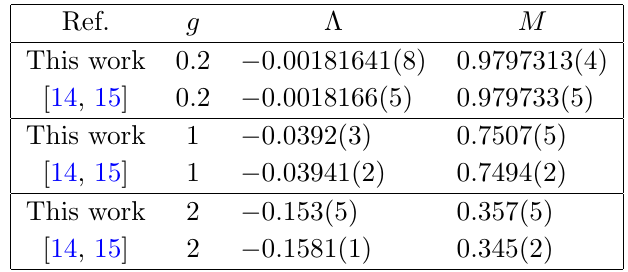
Table 5 . Computation of g c using Borel Resummed Perturbation Theory (RPT), Hamiltonian Truncation (HT), Matrix Product States (MPS) and Lattice Monte Carlo (LMC) methods.